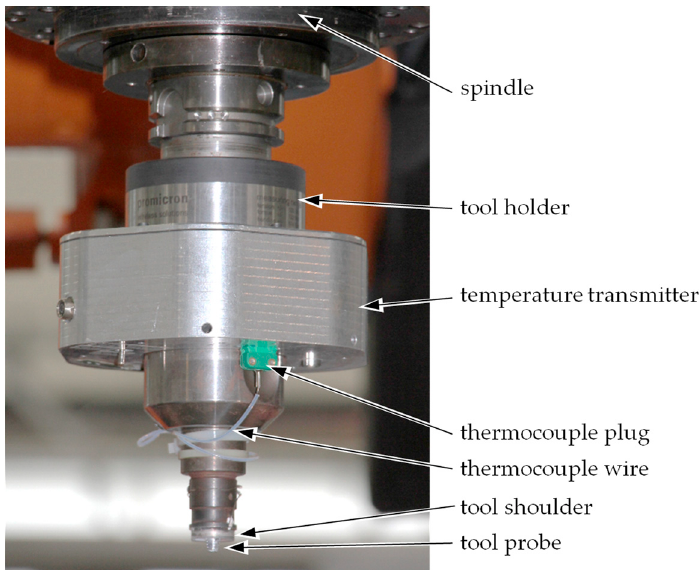
Figure A1. Close-up photograph of the tool with the thermocouple and the temperature transmitter.